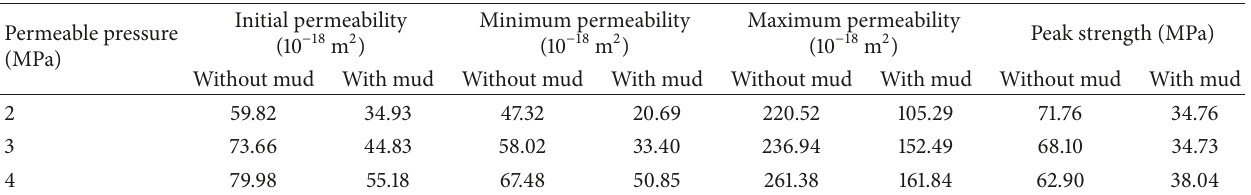
Table 4: Permeability and strength considering confining pressure 6MPa and different water pressure. Permeable